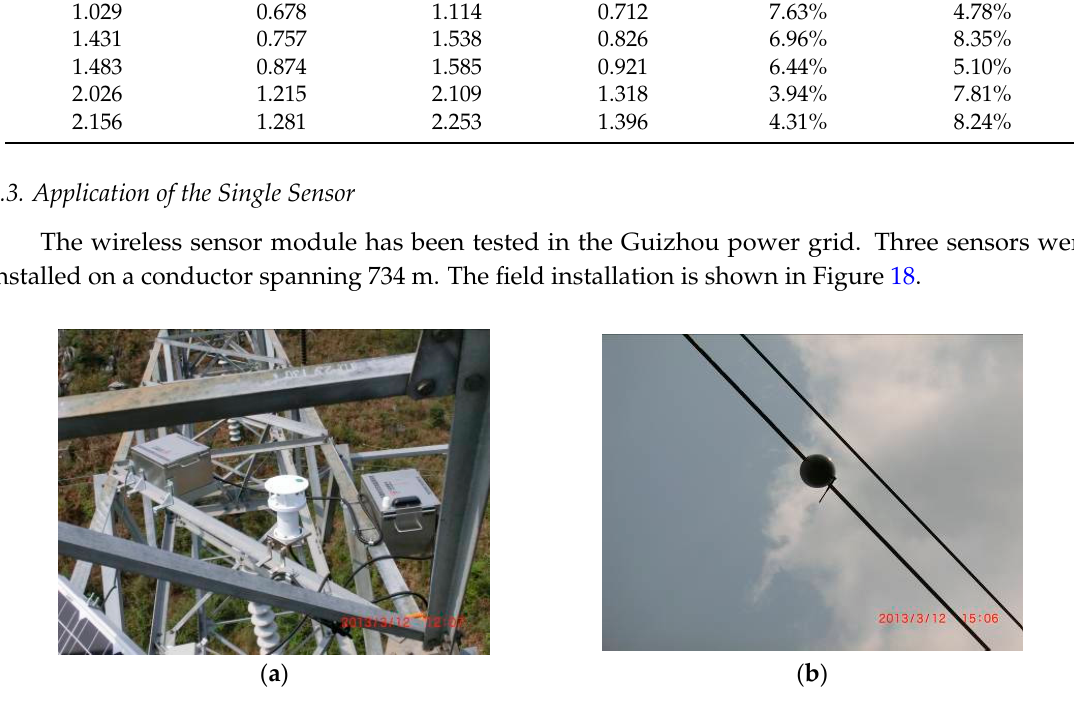
Figure 18. Field installation of the wireless sensor module. ( a ) CMD; ( b ) wireless sensor.